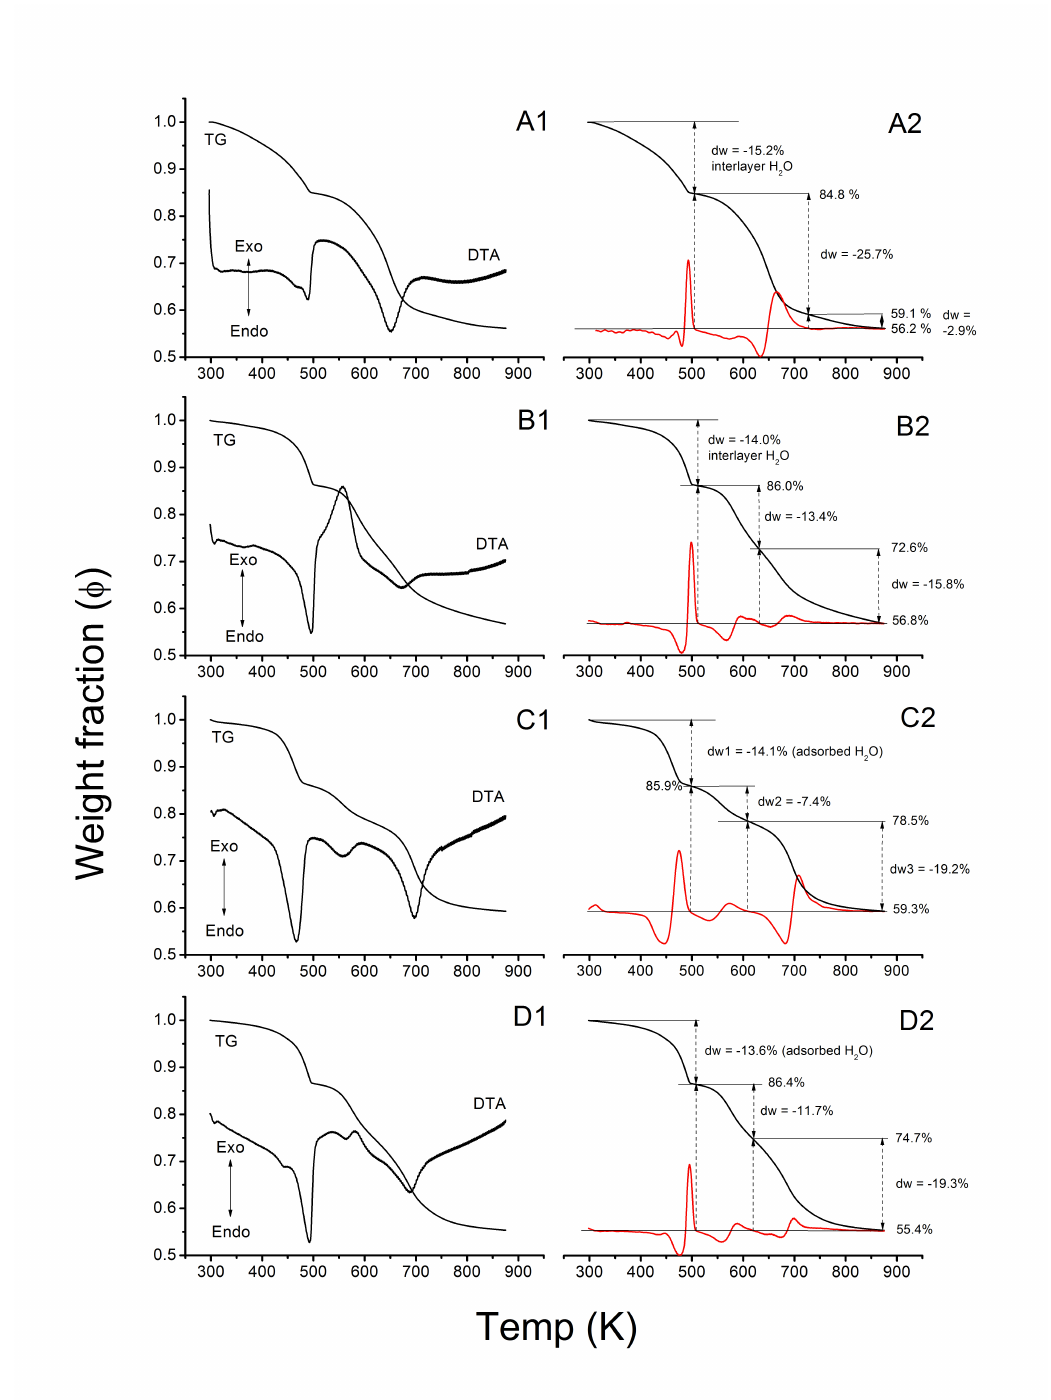
Figure 3. The weight fraction ( φ ) for LDH-OH ( A ); LDH-C ( B ) and LDH-U ( C ) particles is plotted as a function of temperature (T); Commercial HT ( D ) is shown as a reference. Endo- and exotherms are presented in ( A 1– D